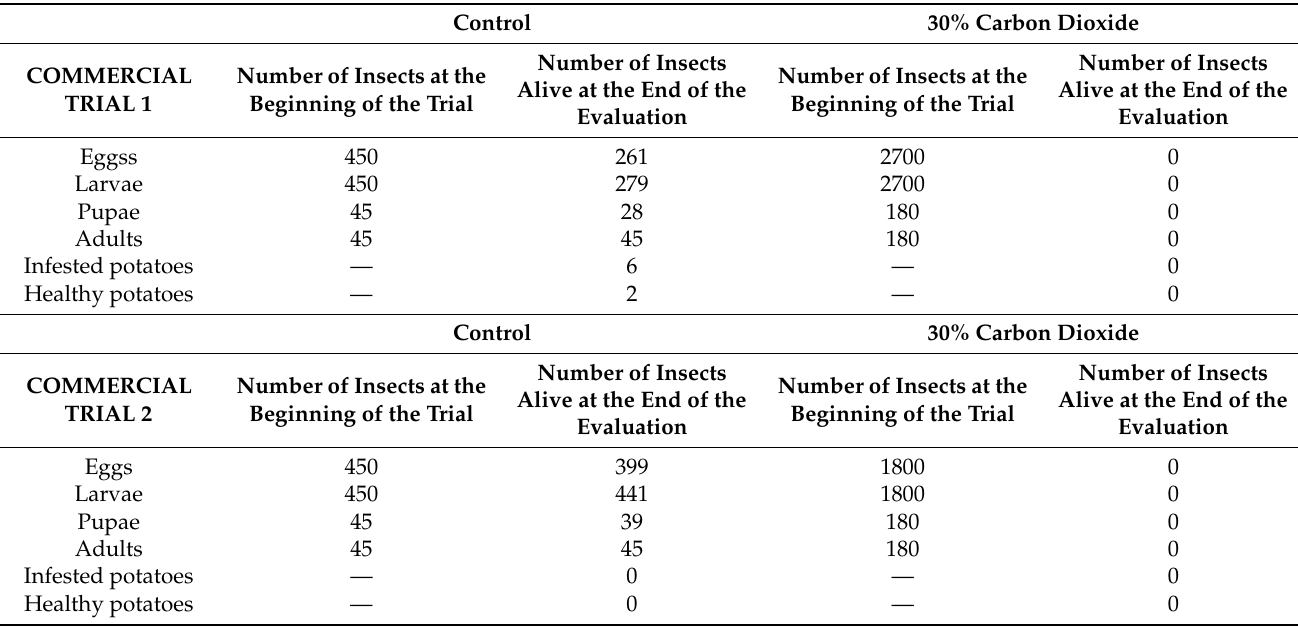
Table 5. Effects of 10-day treatment with 30% CO 2 , 20% O 2 , and 50% N 2 controlled atmosphere at 17 °C on survival of Tecia solanivora at different life stages in commercial trials.